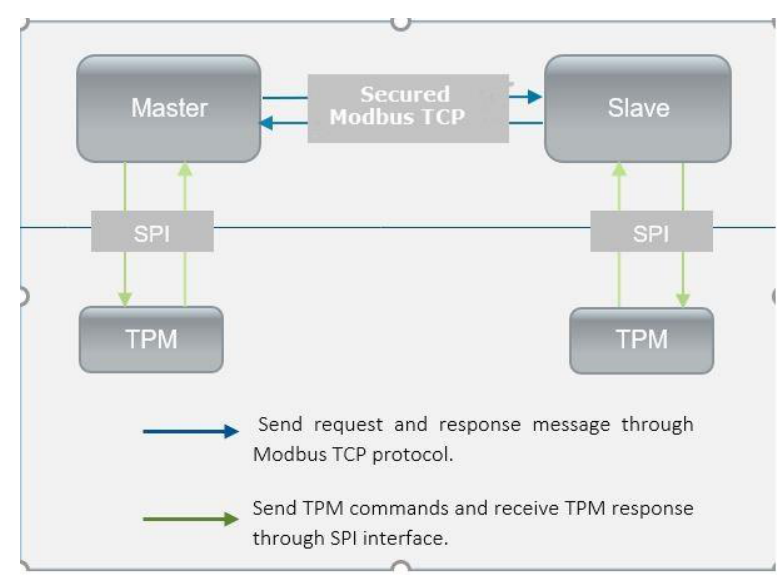
Figure 2. System architecture abstract view.